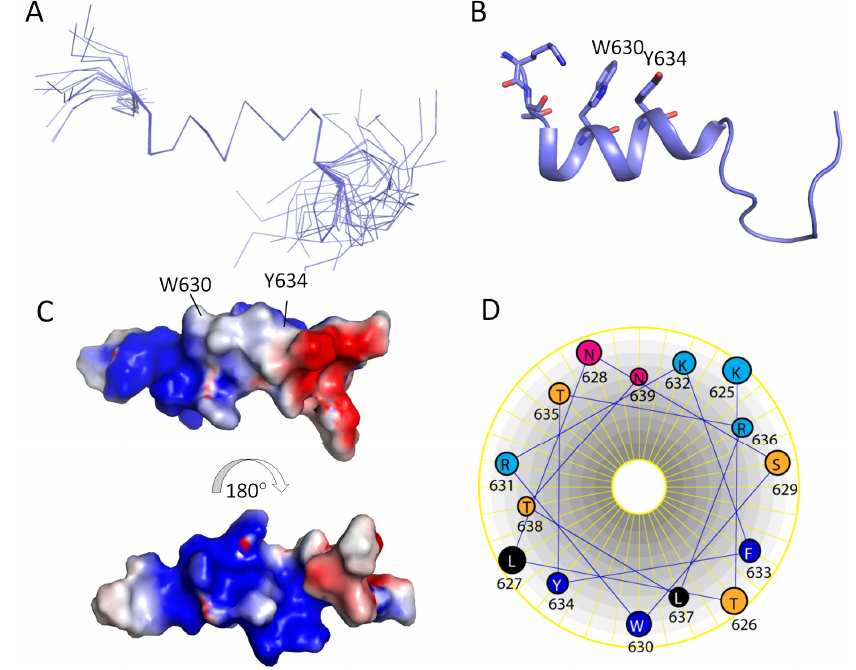
Figure 4. Structure of the peptide in SDS micelles. ( A ) Superimposed structures with lowest energy. Only backbone atom traces are shown. ( B ) Cartoon representation of the structure. The Trp and Tyr residues are shown in sticks. ( C ) Surface representation of the peptide structure. The charge representation of the helical surface and the figures